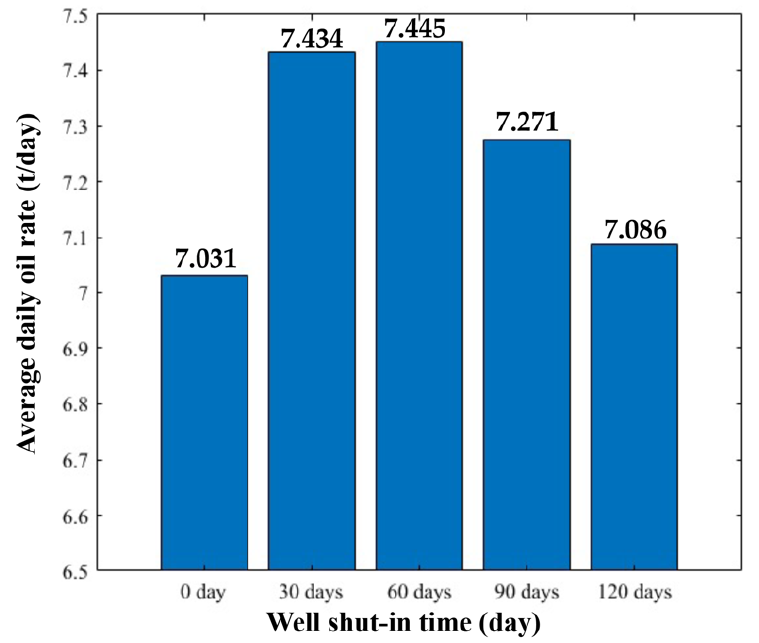
Figure 11. The comparison of average daily oil rate between different well shut ‐ in time cases.